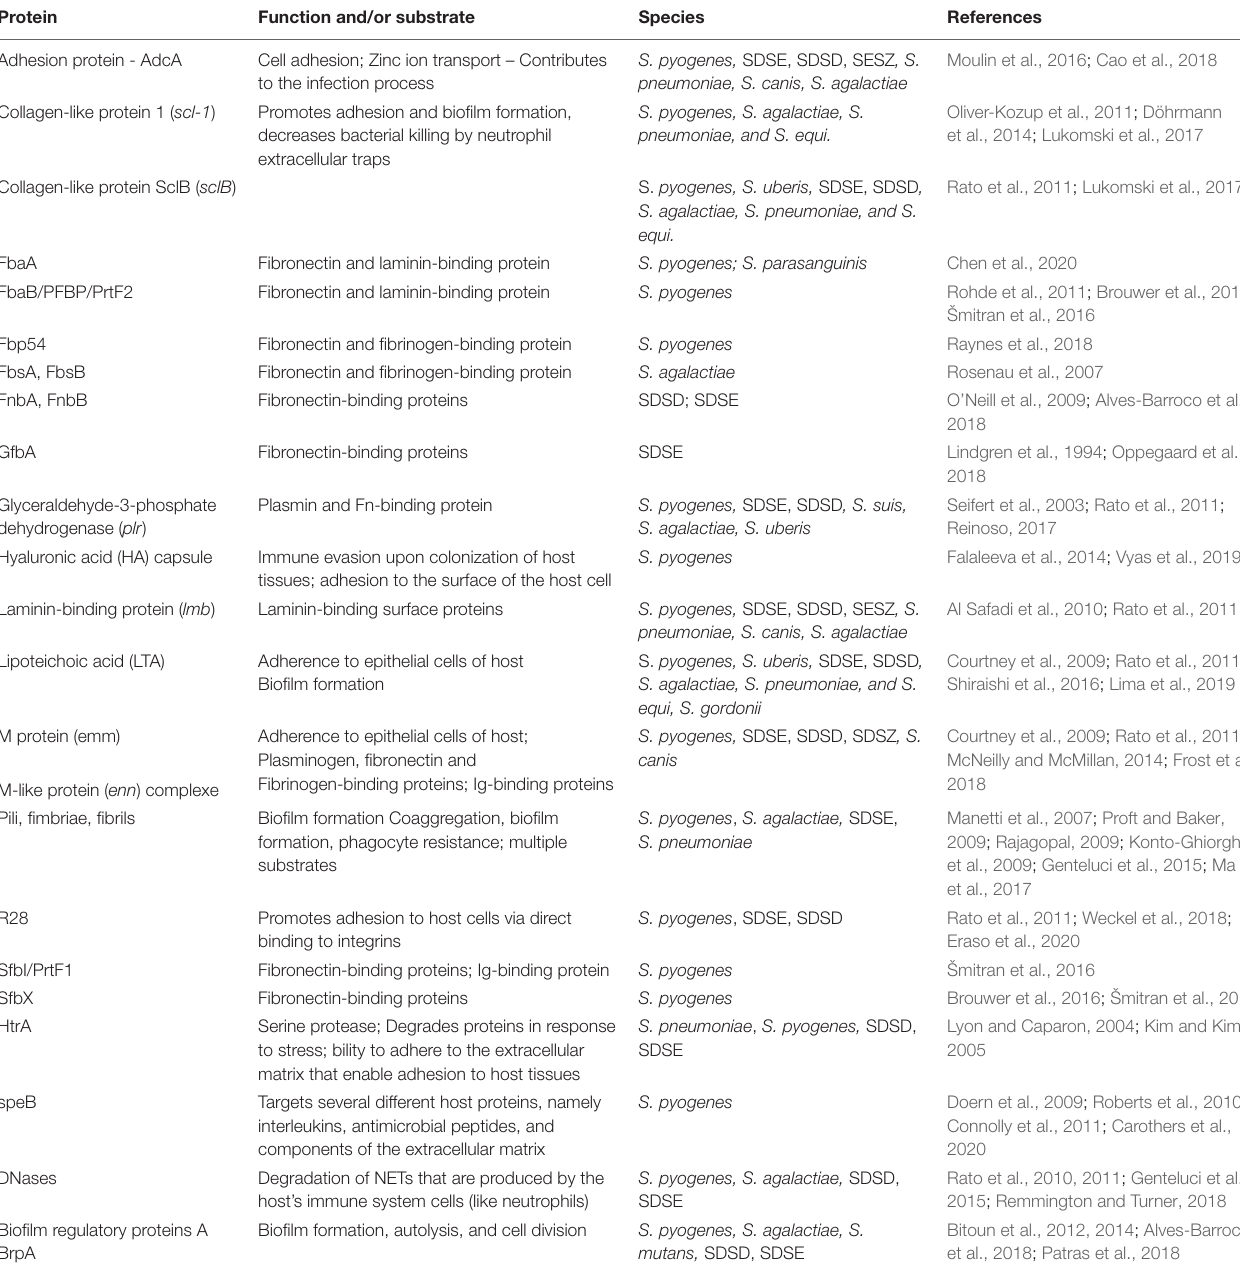
TABLE 2 | Streptococci virulence factors involved in biofilm